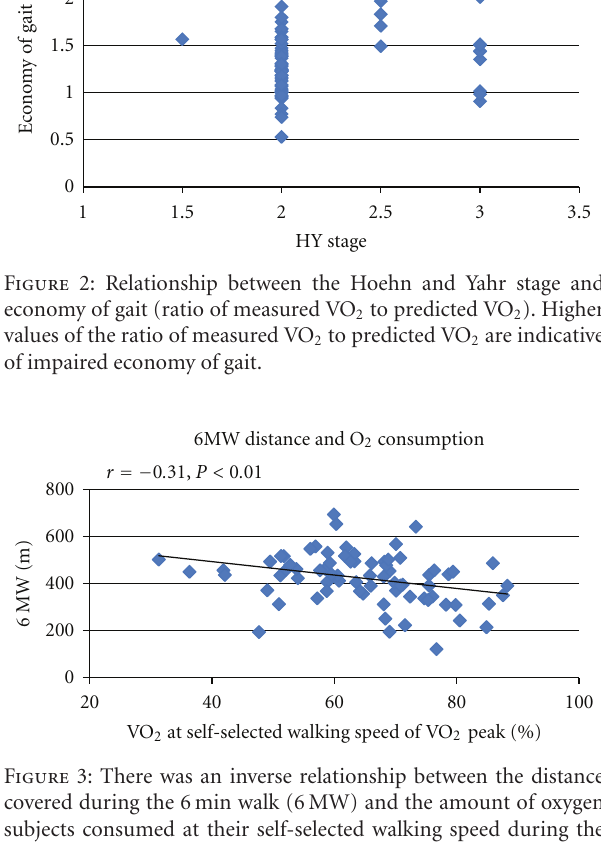
Figure 3: There was an inverse relationship between the distance covered during the 6min walk (6MW) and the amount of oxygen subjects consumed at their self-selected walking speed during the first stage of the treadmill expressed as a percentage of their VO 2